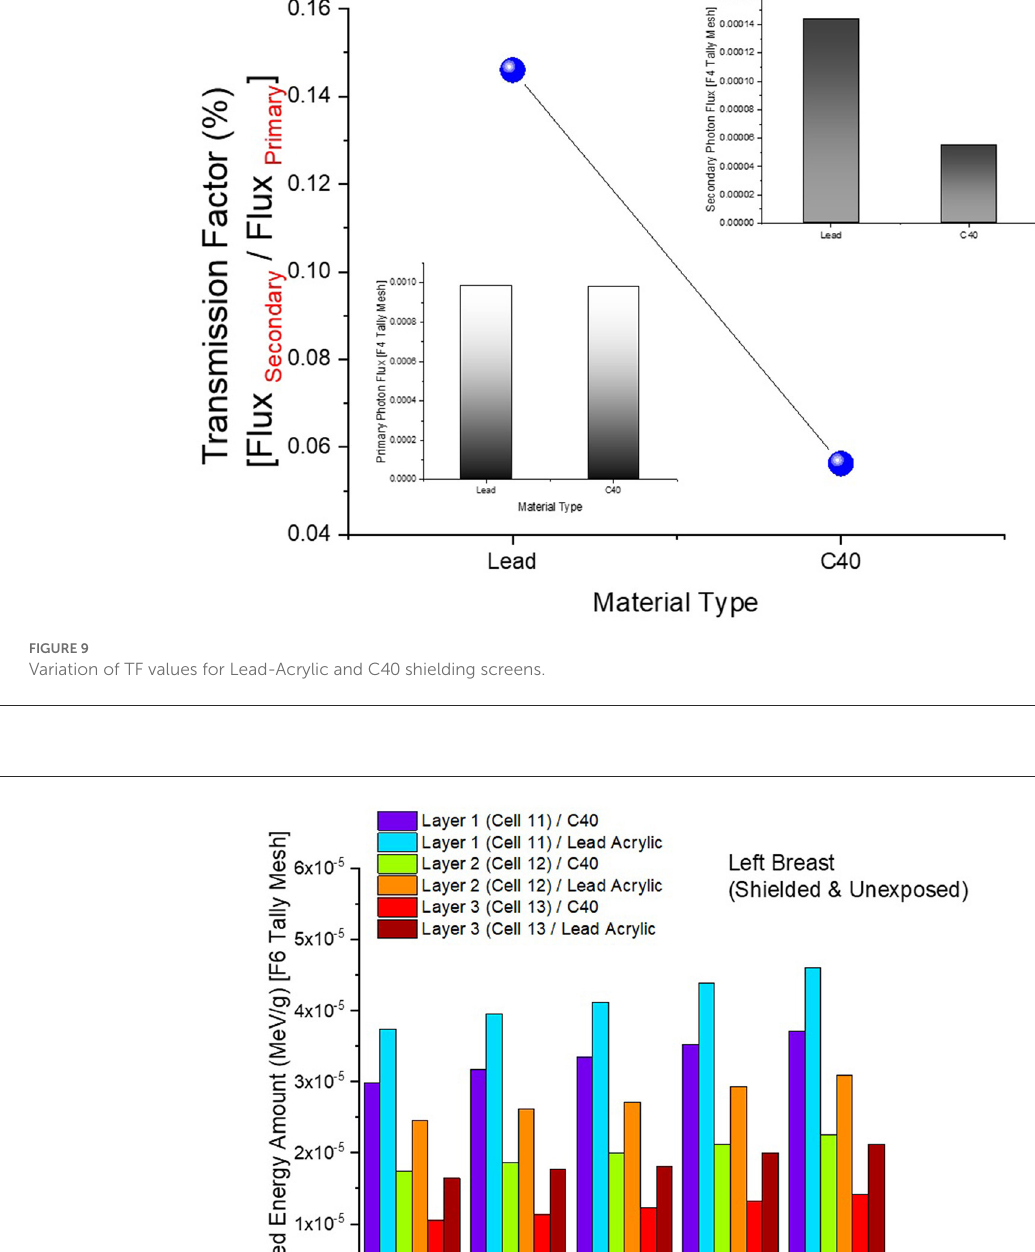
protective screens. As seen in Figure 11, the total dose received by the exposed right breast increased as the energy level